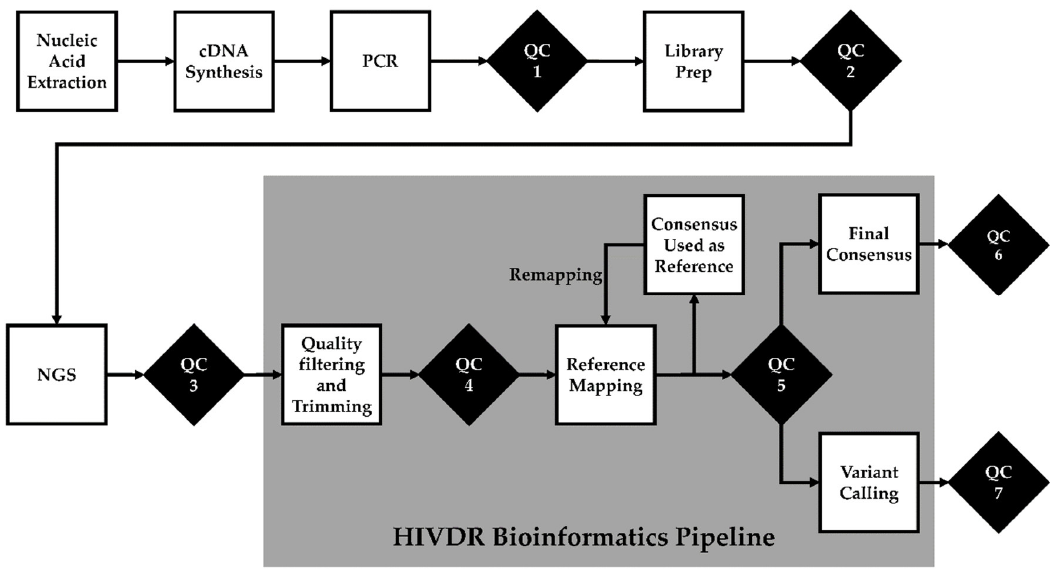
Figure 1. Quality control (QC) checks in NGS-based HIV drug resistance testing. QC1: post-PCR quality check. QC2: library preparation quality check. QC3: post-sequencing run quality